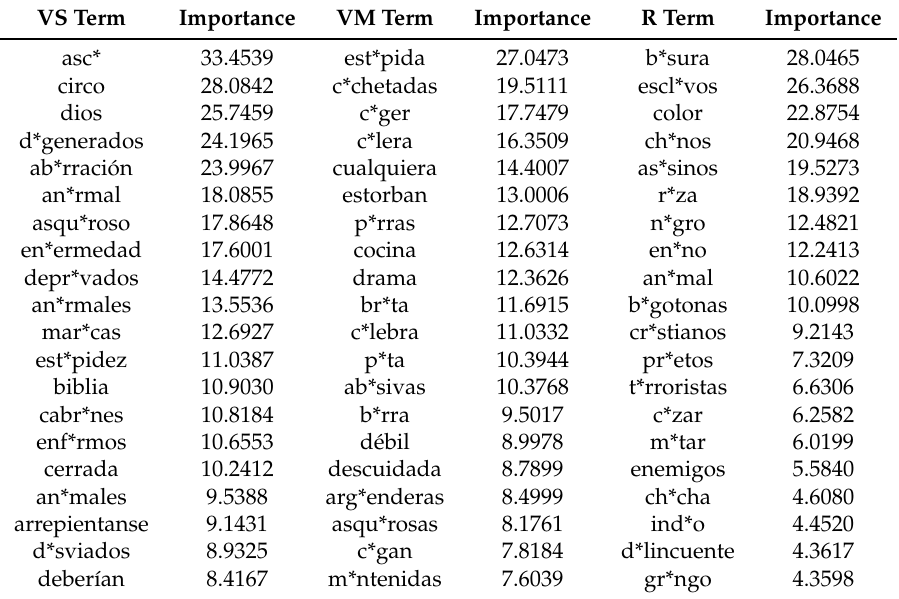
Table 2. Results of the importance of the terms in the feature-selection